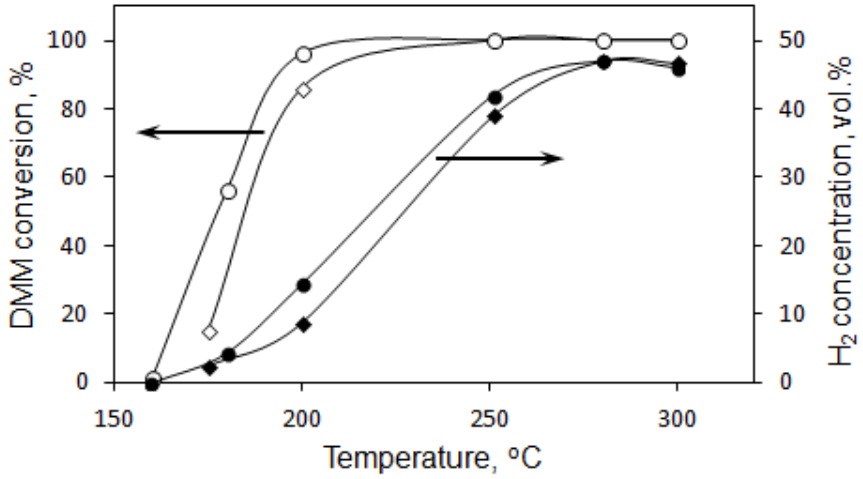
Figure 3. Effect of temperature on DMM conversion and outlet H 2 concentration in DMM